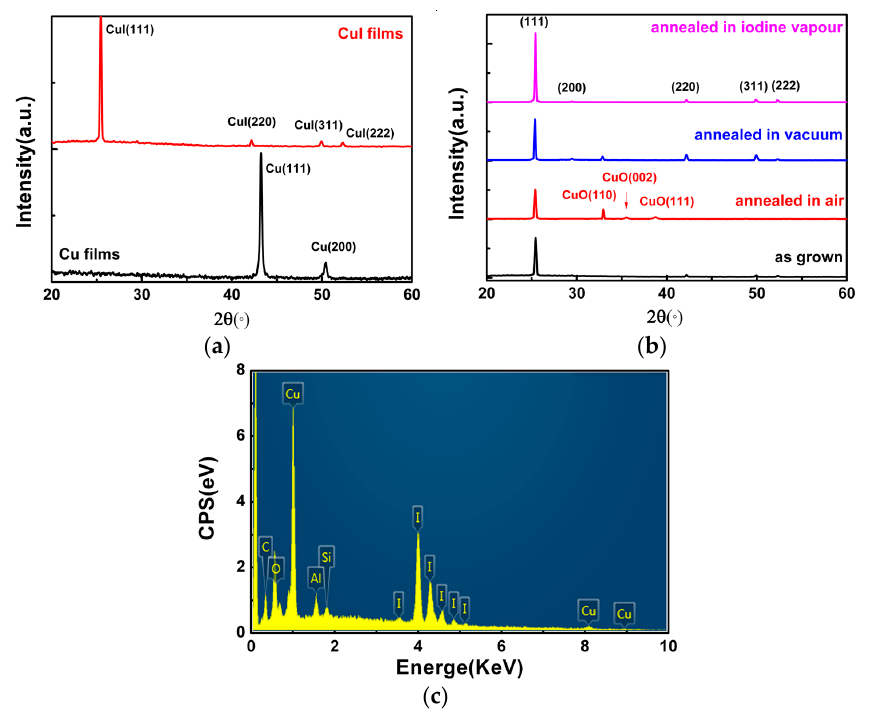
Figure 2. ( a ) XRD patterns of Cu films and CuI films; ( b ) XRD patterns of CuI films with and without annealing treatment; ( c ) EDXA result of the CuI films.